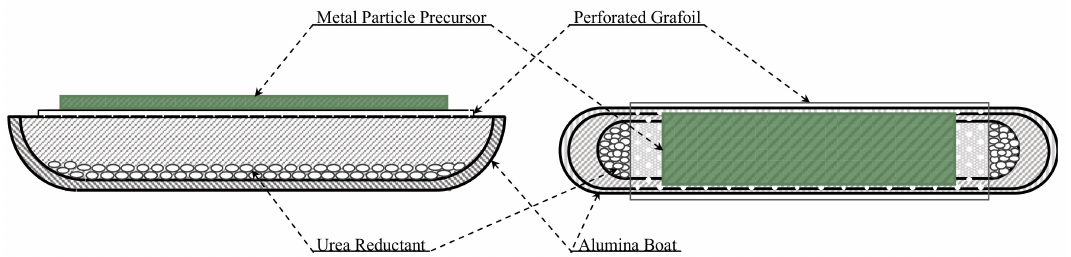
Figure 1. RES-SM Precursor Geometry—As shown, urea is placed in the bottom of an alumina ‘boat’ of dimension 3 cm × 1.5 cm × 1 cm. Grafoil with a high density of pin holes (‘open’ area approximately 25% of total) rests on the top of the alumina boat. The compact, made of Ni and NiO particles, is arranged on top of the